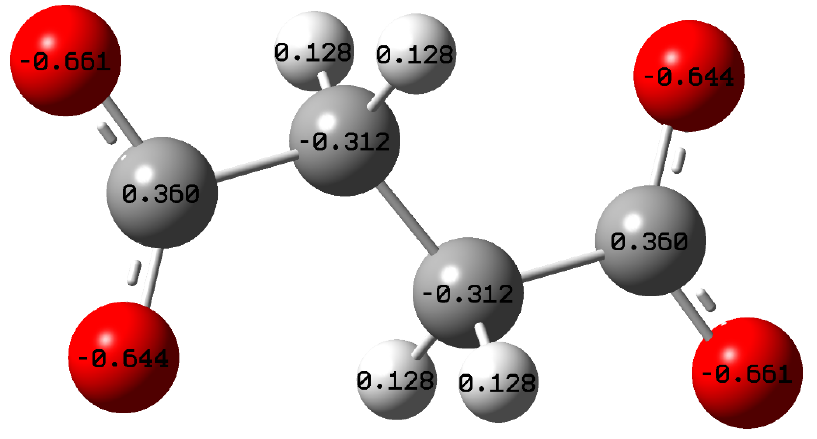
Figure 16. Optimized Geometry of succinate anion with the atomic Mulliken charges using DFT at the B3LYP/6–31 (d, p) basis set level.